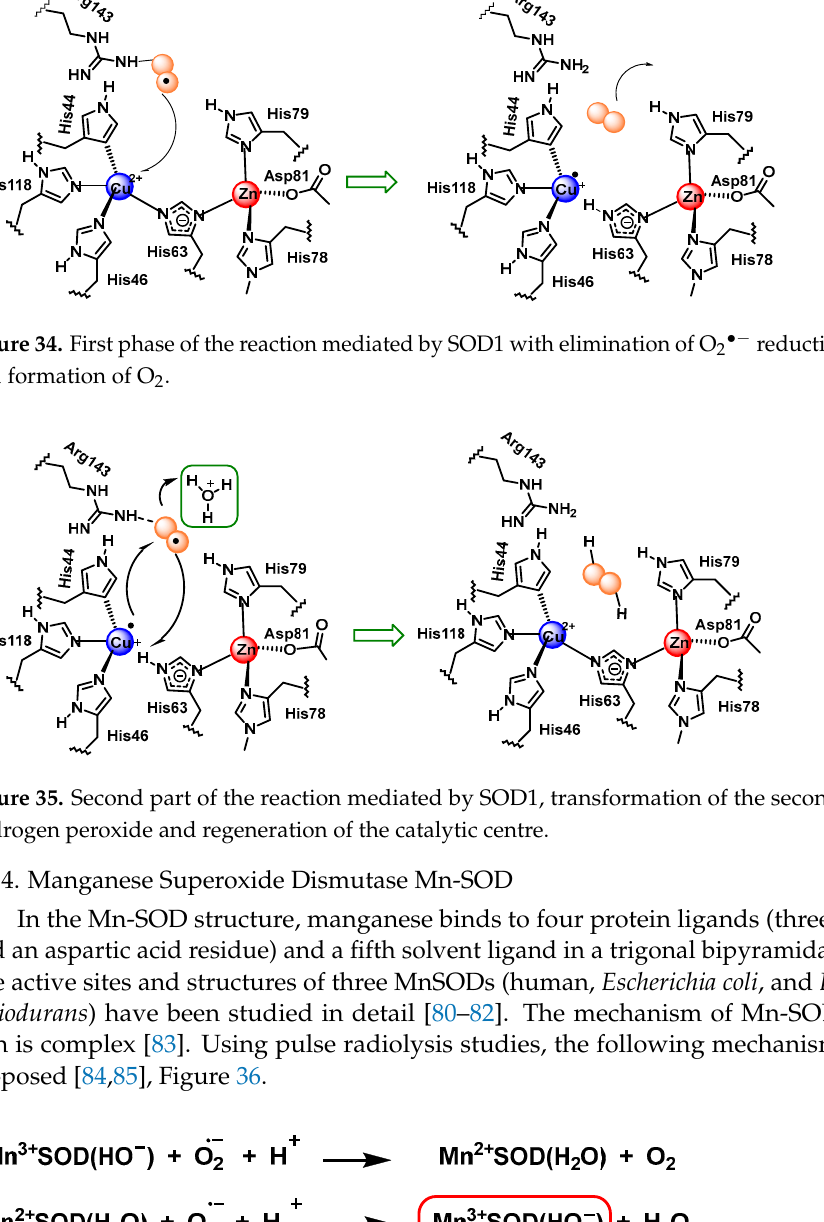
Figure 34. First phase of the reaction mediated by SOD1 with elimination of O 2•– reduction of copper and formation of O 2 .